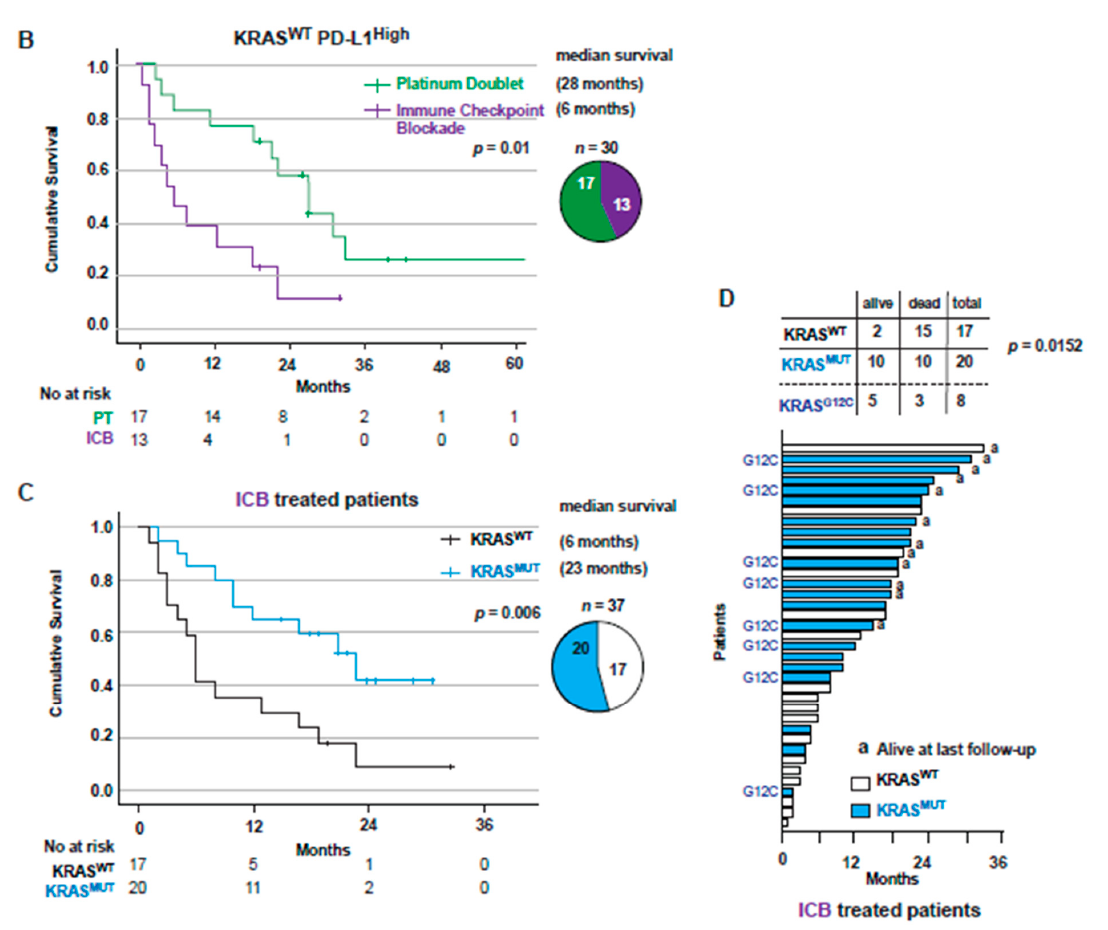
Figure 5. KRAS MUT patients have a better outcome on ICB treatment than KRAS WT patients . ( A ) Kaplan–Meier estimates comparing overall survival for KRAS MUT PD-L1 ≥ 50% treated patients re-